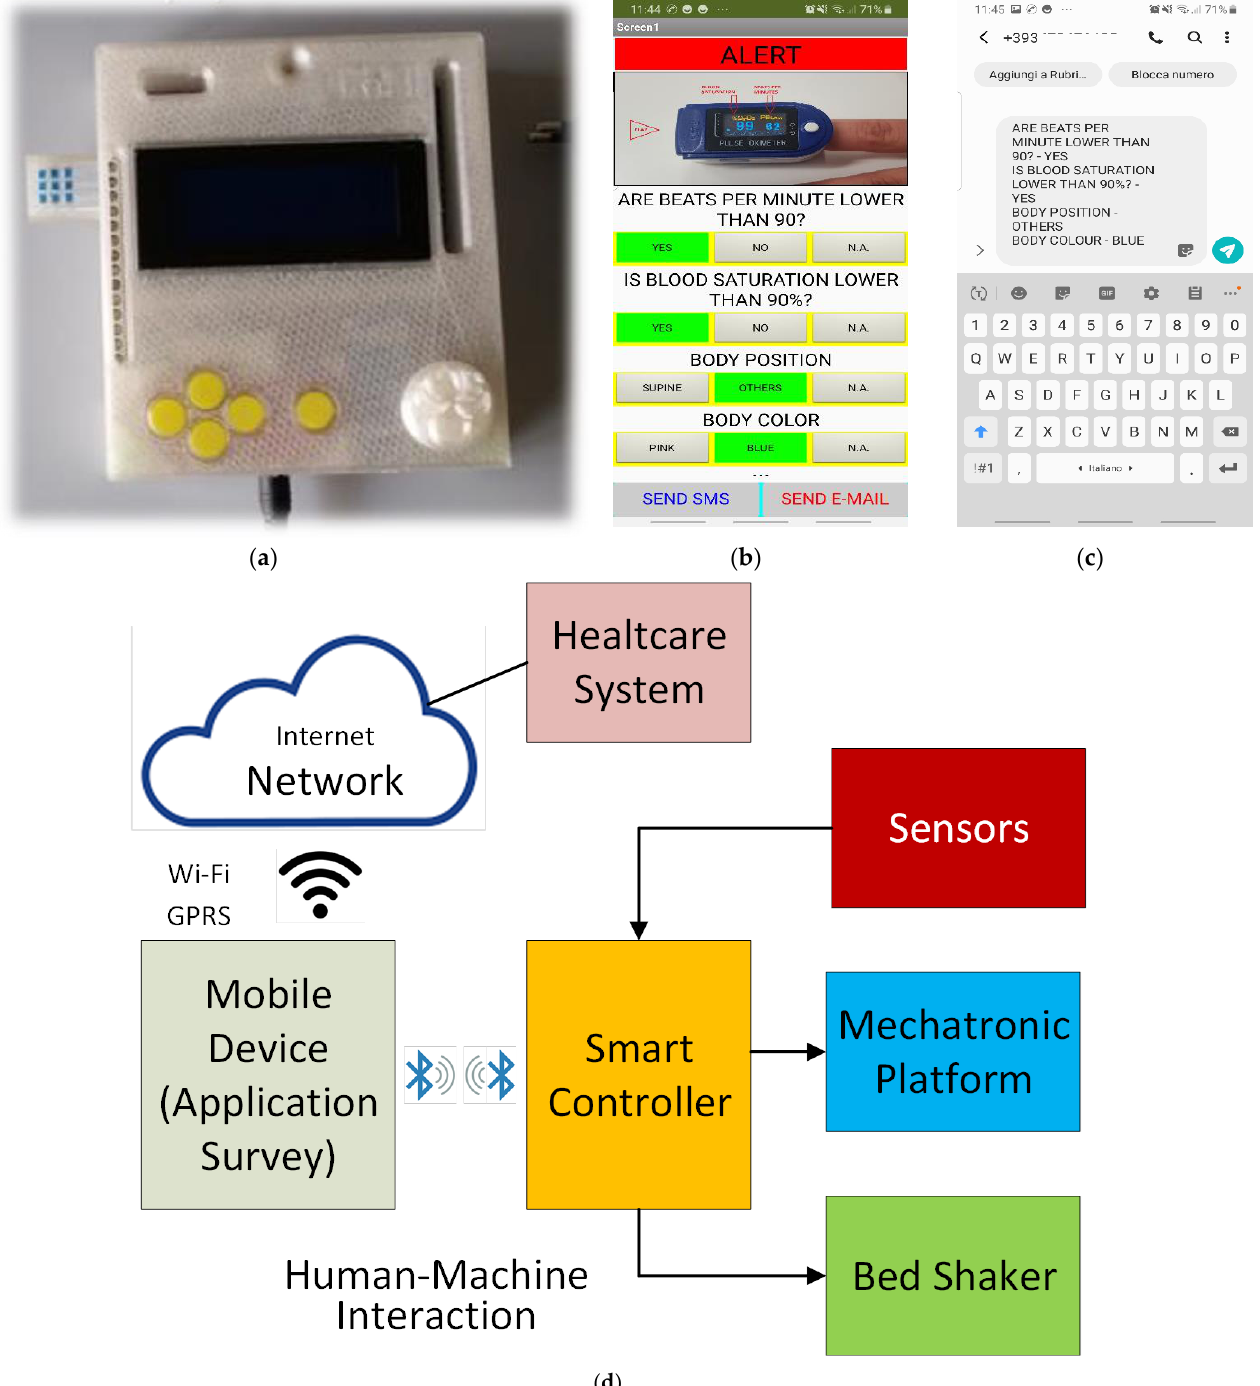
Figure 5. Smart platform: ( a ) smart controller, ( b ) mobile application survey, ( c ) SMS text automat- ically generated, ( d ) smart framework block diagram.